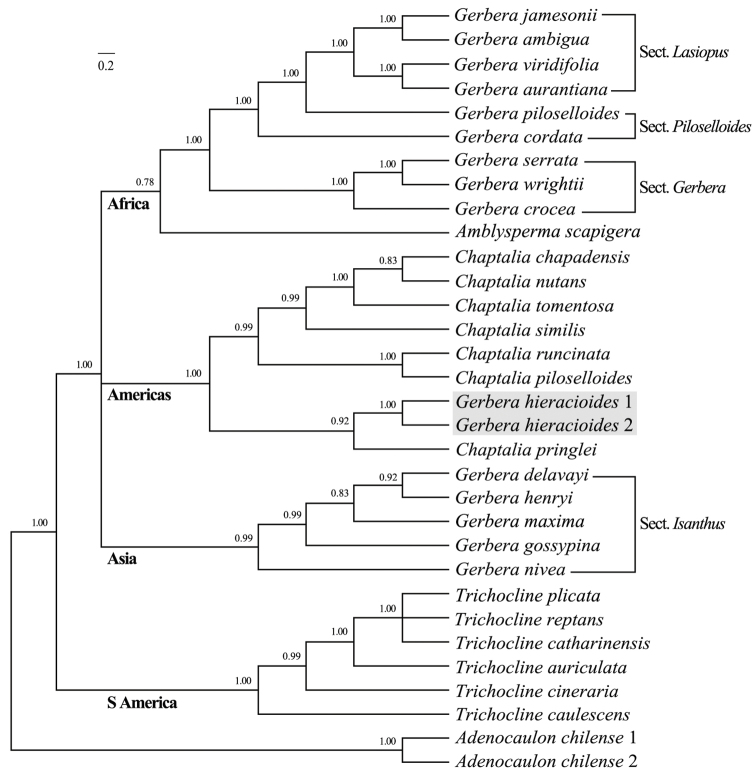
Phylogeny of Gerbera
hieracioides and the related species. The phylogeny is based on the MrBayes analysis of the combined ITS and ETS, trnL–trnF and trnL–rpl32 markers. The posterior probabilities support values are shown next to branches.